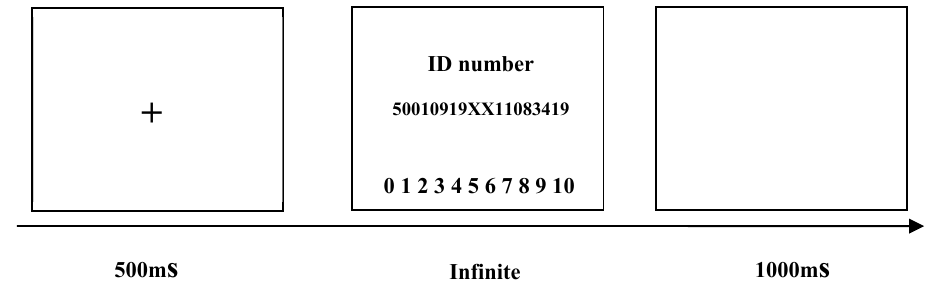
Figure 1. The experimental process of repeated dictator games.